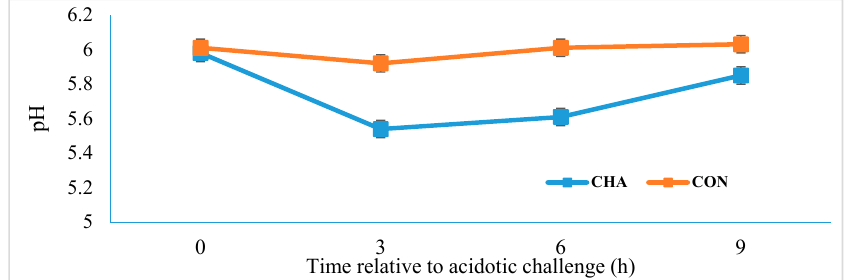
Figure 1. Rumen pH of beef cattle during acidosis challenge. CHA = corn-induced acidotic challenge, CON = control (no challenge).